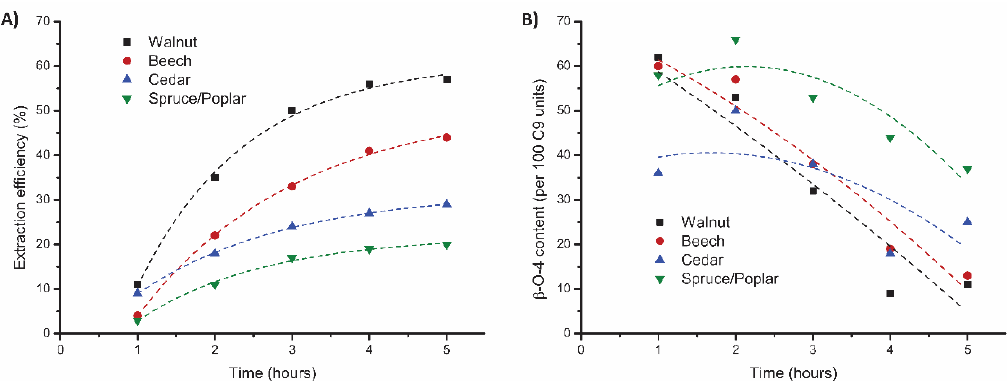
Figure 8. Influence of the feedstock on the mild organosolv extraction (95:5 EtOH/H 2 O, 0.18 M H 2 SO 4 , 120 °C, 5 h) on ( A ) extraction efficiency (corrected for alcohol incorporation as determined by 2D HSQC) and ( B ) total β-O-4 content as determined by 2D HSQC.